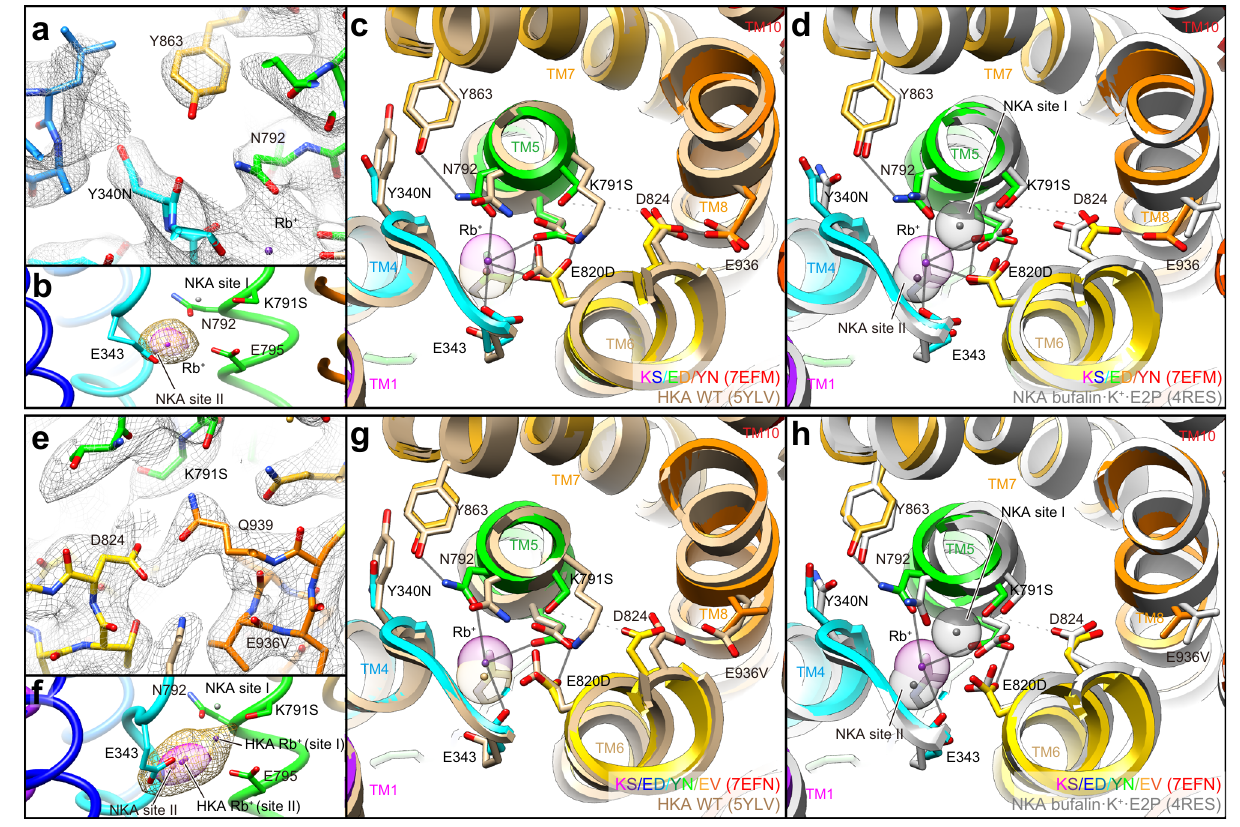
Fig. 3 Crystal structure of the KS/ED/YN triple and KS/ED/YN/EV quadruple mutant of HKA in BYK·K + ·E2BeF form. a , e 2Fo-Fc electron density maps around Tyr340Asn and Tyr836 of HKA triple mutant ( a ) and that around Asp824 and Glu936Val of HKA quadruple mutant (contoured at 1.5 σ ) are shown in mesh representations. b , f Purple surface (6 σ ) and orange mesh (4 σ , same contour level as in Fig. 2) represent the Rb + anomalous Fourier map at the cation-binding site, viewed along the membrane plane. Purple dots indicate the position of Rb + modeled in HKA triple mutant ( b ) or HKA quadruple mutant ( f , both cases of one Rb + or two Rb + modeled are shown). Gray dots represent the two K + ions bound to site I and site II in the bufalin-bound NKA (4RES) in both fi gures. c , d , g , h Cation-binding site structures of the triple ( c , d ) and quadruple mutant ( g , h ), viewed from the cytoplasmic side, are shown with superimposed HKA wild type in SCH·K + ·E2BeF form ( c , g , 5YLV show in wheat) or NKA in bufalin·2K + ·E2P form ( d , h , 4RES, shown in gray), respectively. Residues that likely form hydrogen bonds or contribute to the Rb + coordination in the triple and quadruple mutant are connected with gray lines (within 3.5 Å). Dotted gray lines indicate the distance between Lys791Ser and Asp824 in triple ( c , d , 4.8 Å) and quadruple mutants ( g , h , 4.7 Å), respectively. Models were aligned based on the TM7-TM10 part of the α -subunit. See Supplementary Movies 1 and 2 for the triple and quadruple mutants,